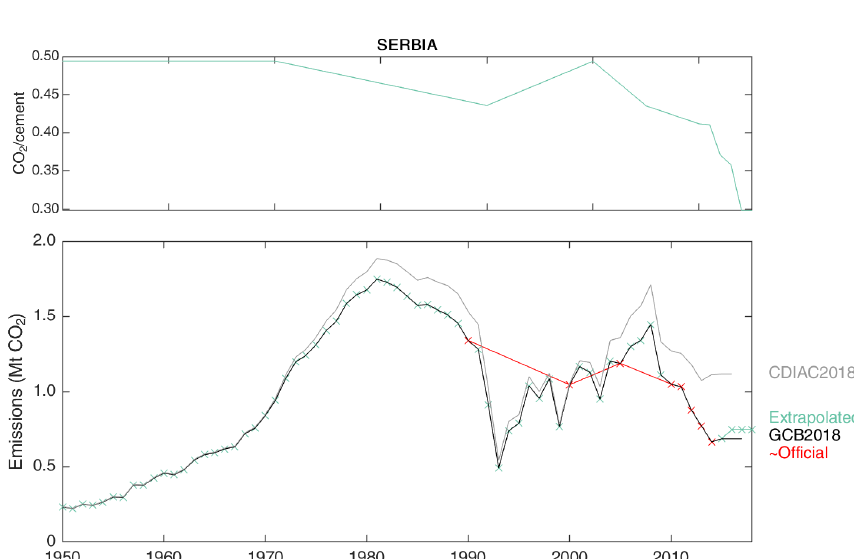
Figure C38. Revised cement emissions for Saudi Arabia.